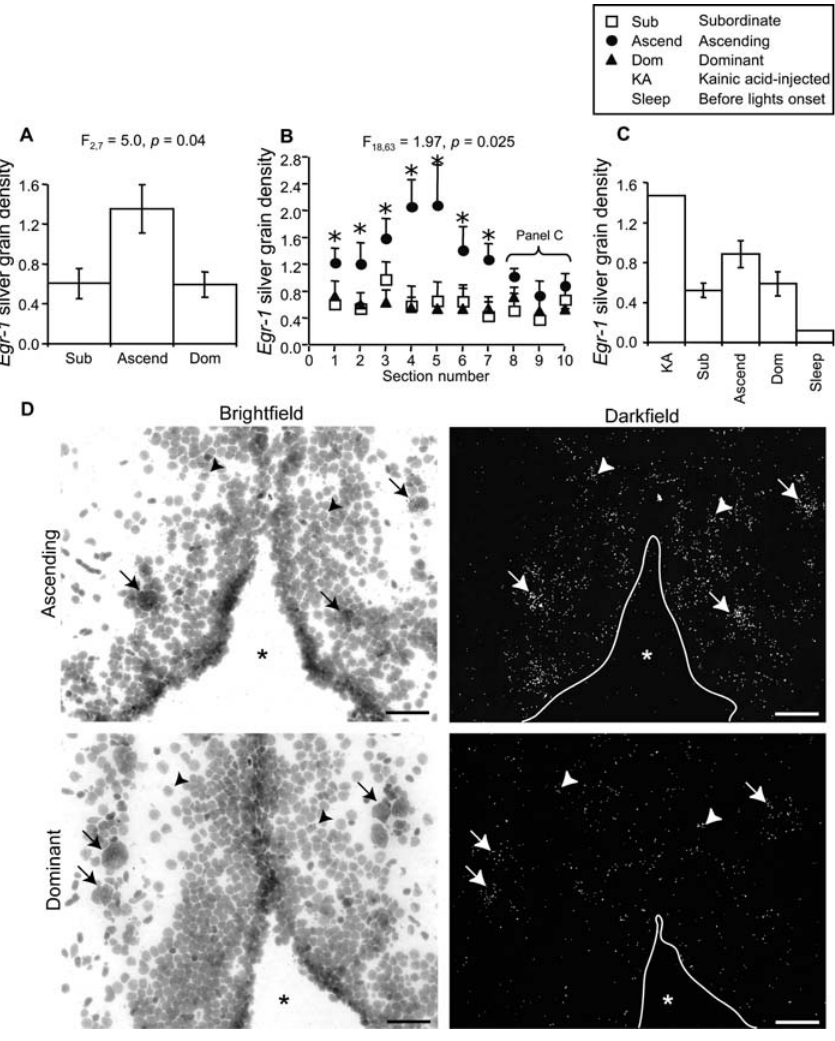
(A) Mean 6 SE silver grain density of the entire aPPn differed among subordinate (Sub), ascending (Ascend), and dominant (Dom) males. (B) Induction of egr-1 (mean 6 SE silver grain density) in the aPPn of ascending males varied with section number (rostral to caudal) as compared to subordinate and dominant males. Asterisks represent contrasts with p , 0.05. (C) Mean 6 SE silver grain density in the three caudal-most sections of the aPPn of subordinate, ascending, and dominant males compared to a male injected with kainic acid (KA) and a male sacrificed just before onset of lights (Sleep). (D) Photomicrographs of egr-1 expression in the aPPn of an ascending male (top) and a stable dominant male (bottom). We chose representative males and sections to be close to group means for the central aPPn. Arrows indicate examples of egr-1 -expresssing GnRH1 neurons identified by their distinctly large cellular morphology, arrowheads indicate examples of non-GnRH1 neurons, and the asterisks indicate the preoptic recess of the third ventricle. Scale bars represent 40 l m. DOI: